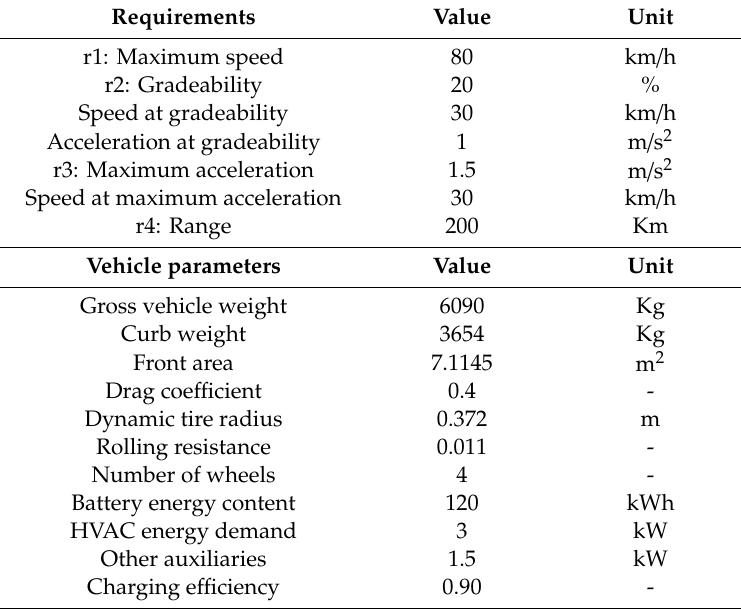
Table 1. Vehicle requirements and parameters